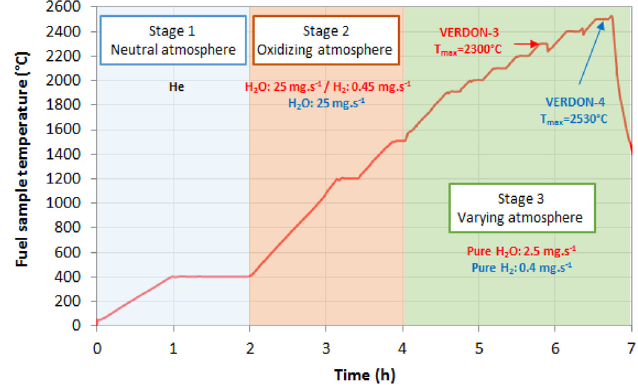
Fig. 1. Thermal sequence of the VERDON-3 and